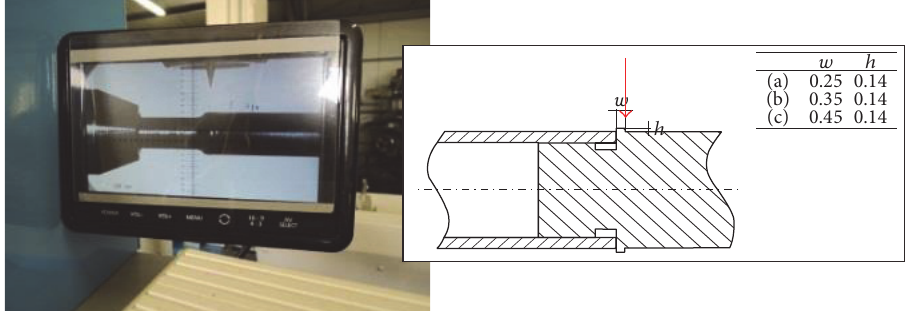
Figure 4: Alignment between weld joint and electrode.